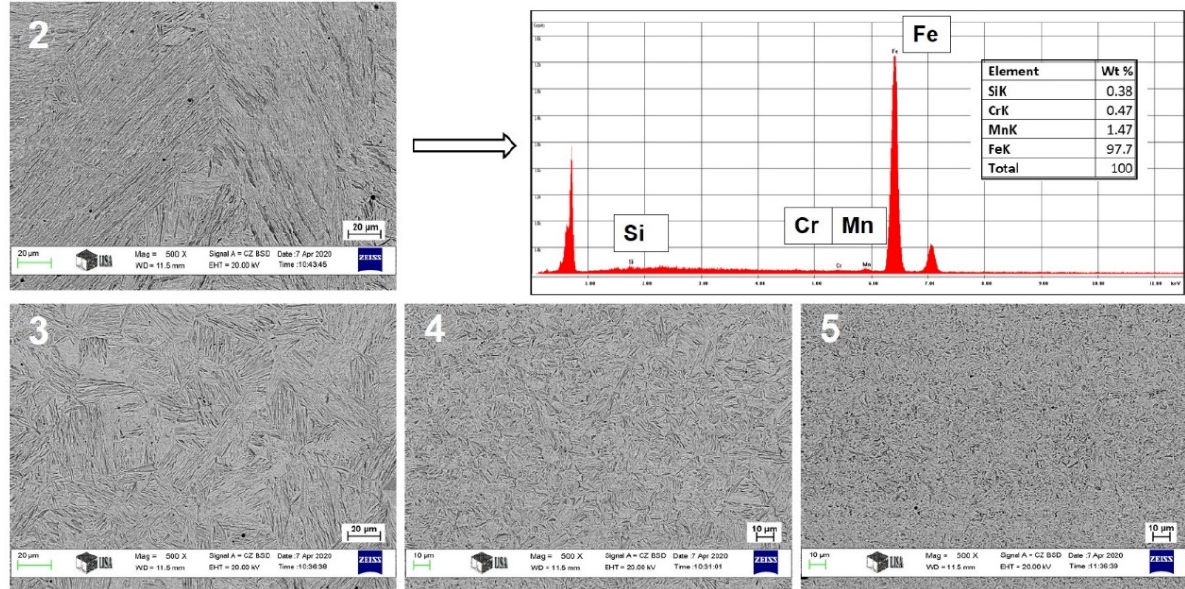
Figure 5. SEM micrographs of different subzones of the EB-welded joint, S960Q steel. 2—Fusion zone and EDS spectrum of FZ; 3—CGHAZ; 4—FGHAZ; 5—ICHAZ (2% Nital).